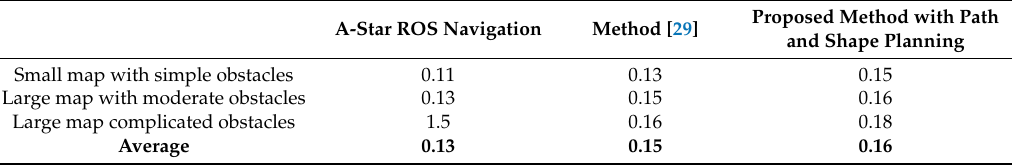
Table 4. The running comparisons of plan generating